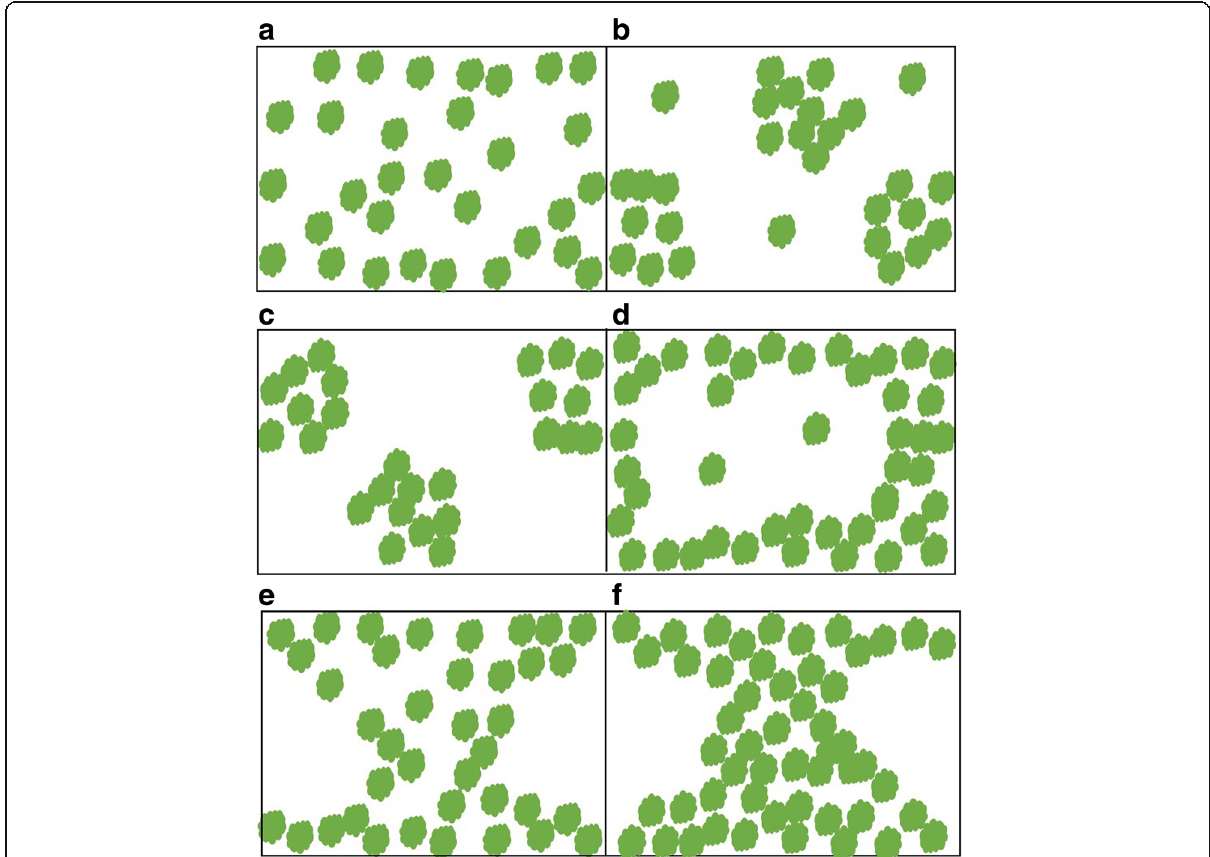
Fig. 6 Conceptual representation of various types of variable retention harvesting in red pine ecosystems. Retention may be implemented as dispersed trees ( a ) or aggregated with or without some dispersed trees in the harvested matrix ( b , c ). Alternatively, retention may be implemented as large gap (patch) openings with a few retained trees in the opening ( d ) or as smaller patch openings with or without thinning of the forest between the openings ( e , f )